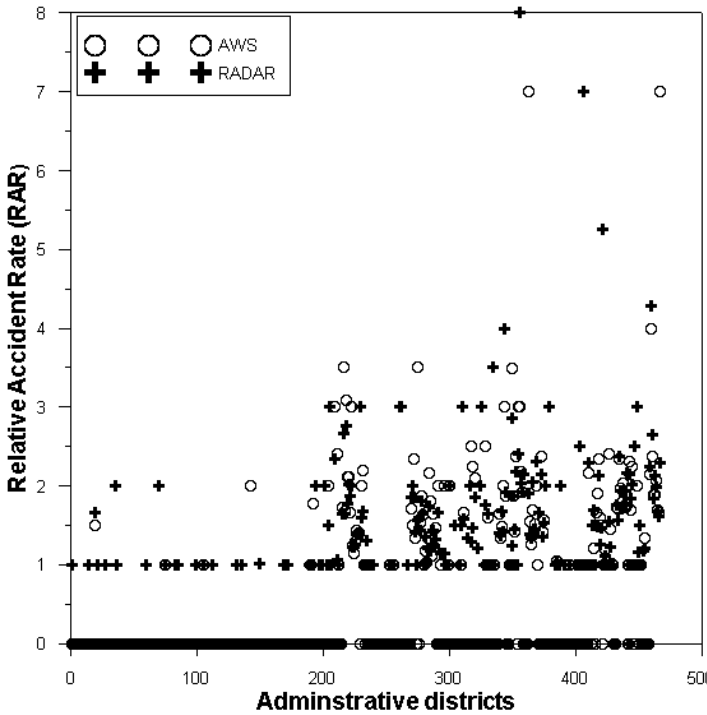
Figure 8. RAR for all 467 administrative districts in Seoul (fatal and severe accidents during rainfall).